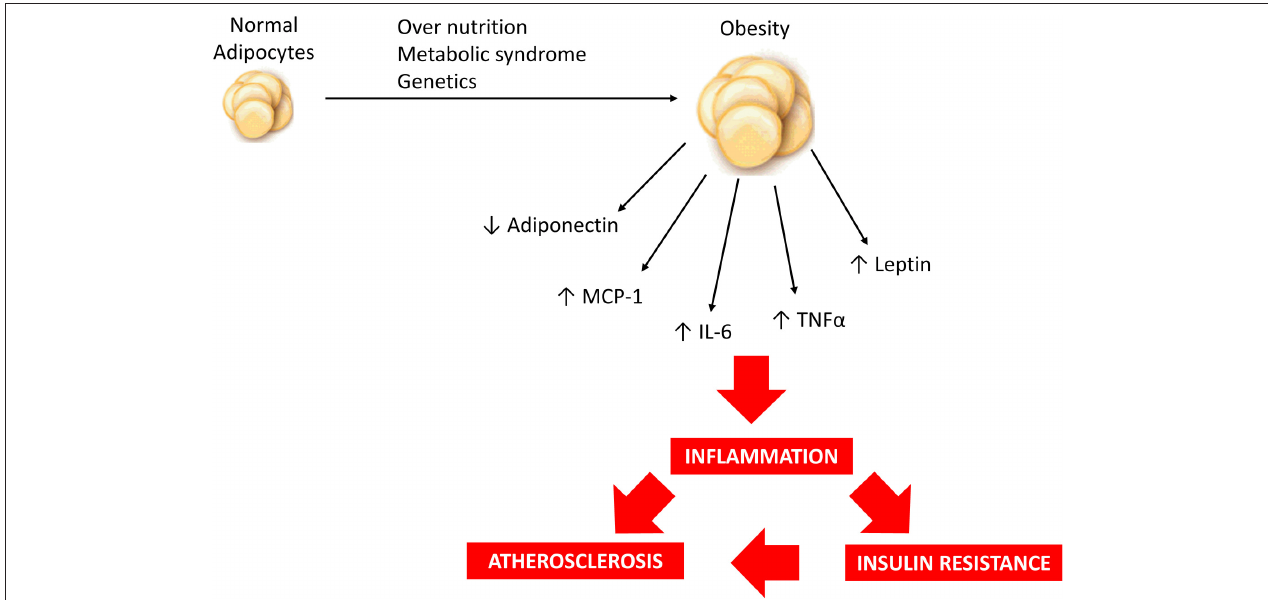
FIGURE 1 | Over nutrition, metabolic syndrome and/or genetic predisposition may contribute to obesity development and modulate adipokine profile resulting in a low-grade inflammatory state which is associated with increased risk of insulin resistance and atherosclerosis.